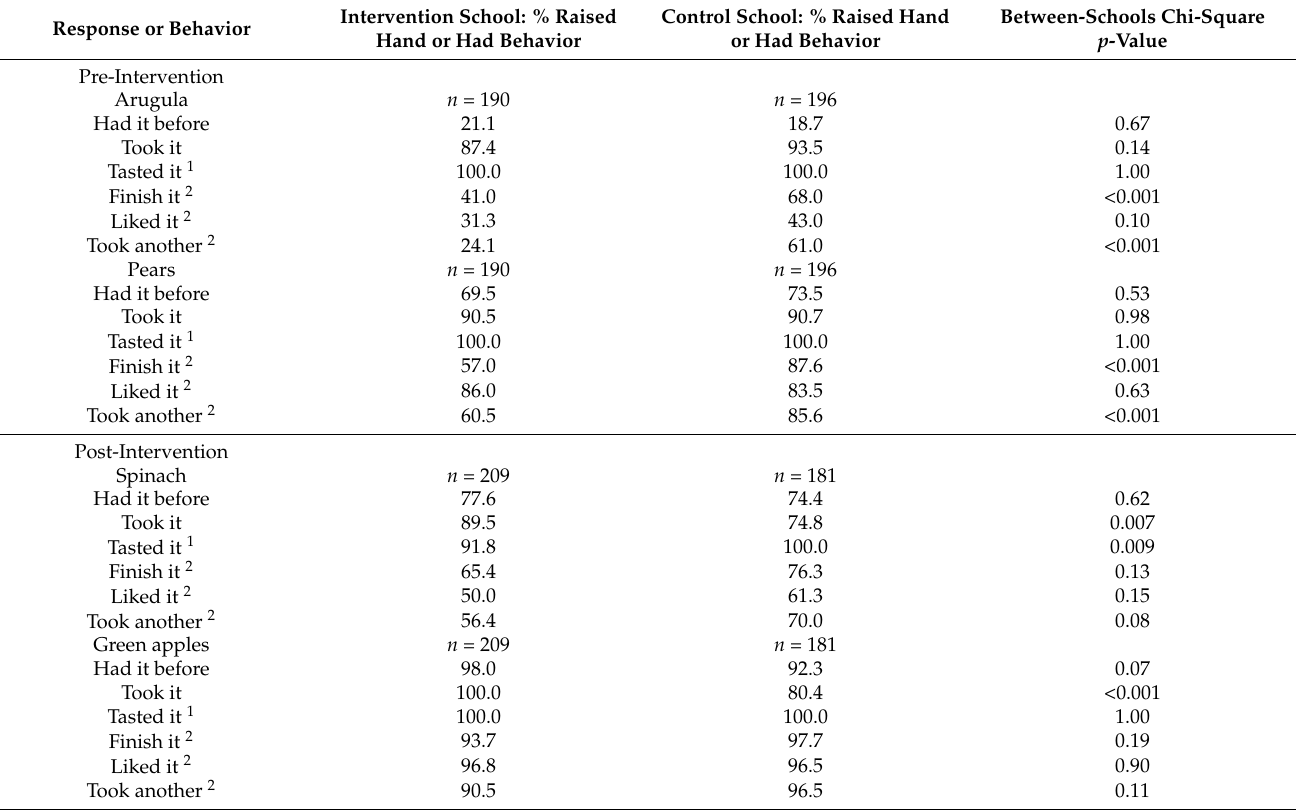
Table 3. Between-schools oral survey responses and behavioral observations comparisons.